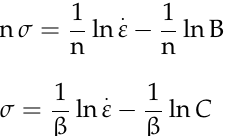
Figure 6. Relationship between stress and strain rate: ( a ) ln σ ∼ ln For all stress states, Equation (9) can be